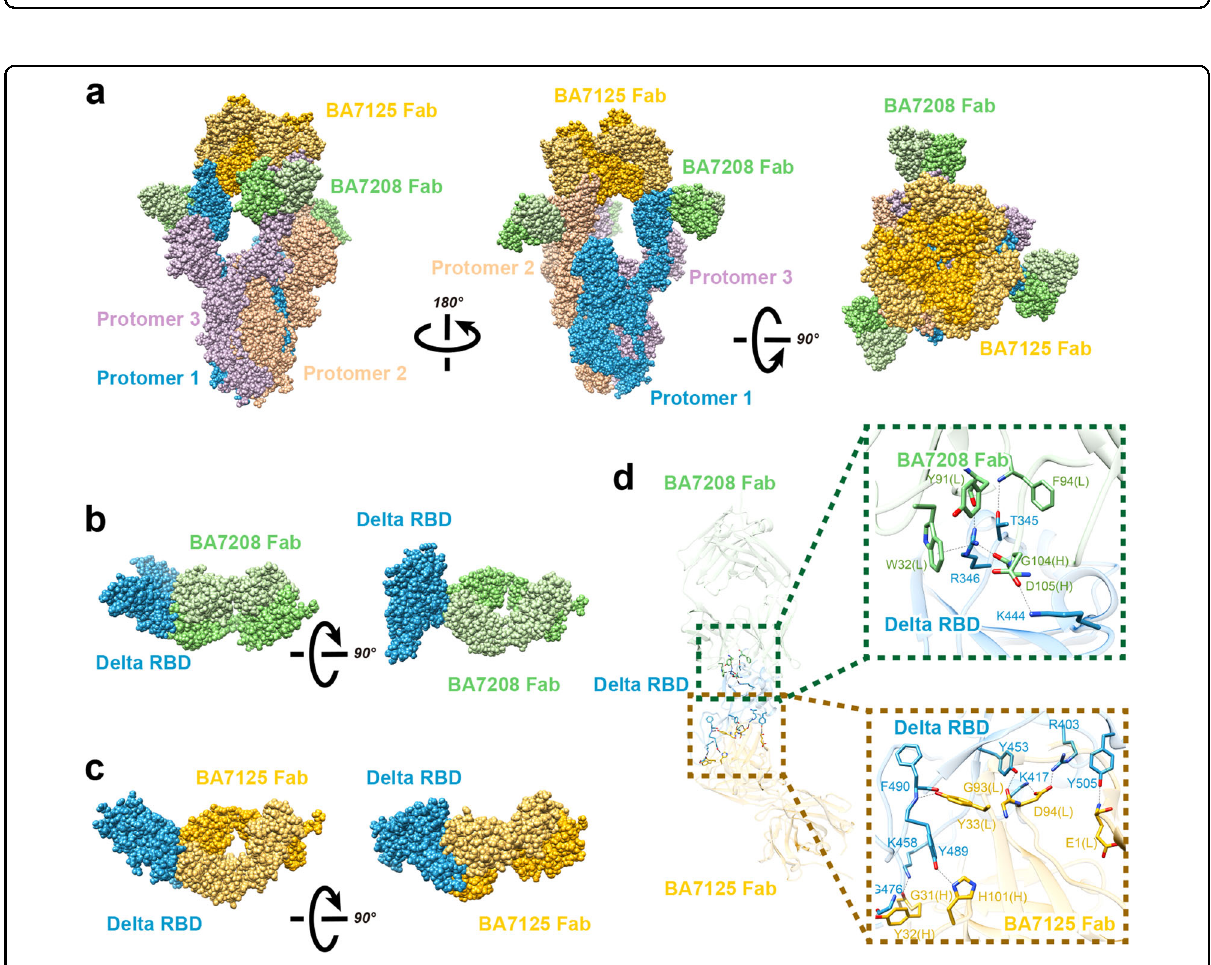
Fig. 3 Cryo-EM of Delta Spike Trimer with BA7208-Fab/BA7125-Fab. a The complex of three BA7208-Fabs (green) and three BA7125-Fabs (yellow) with Delta Spike Trimer (dodger blue, plum, and rosy brown). b The complex of BA7208-Fab (light green, Fab light chain; dark green, Fab heavy chain) with Delta Spike-RBD (dodger blue). c The complex of BA7125-Fab (light yellow, Fab light chain; dark yellow, Fab heavy chain) with Delta Spike-RBD (dodger blue). d Zoomed-in views of Fabs binding sites on Delta RBD. Side chain of residues that form the hydrogen bonds, salt bridge, and one cation- π interaction are